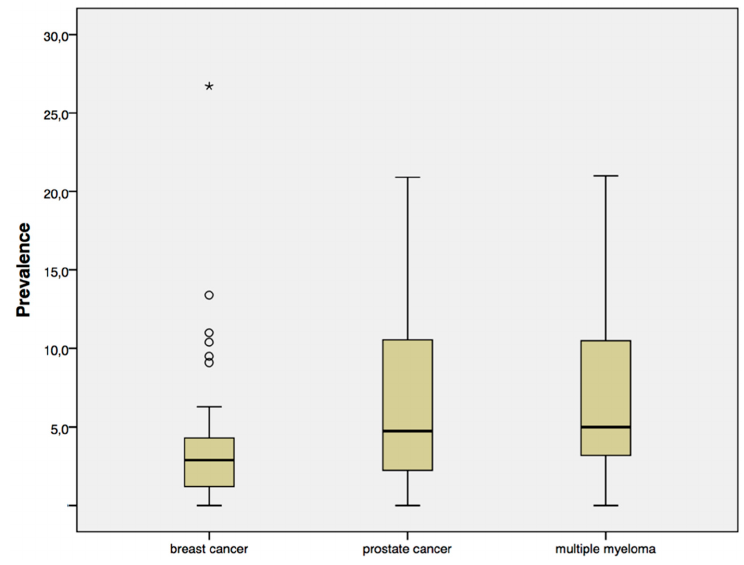
Figure 1. Published prevalences.